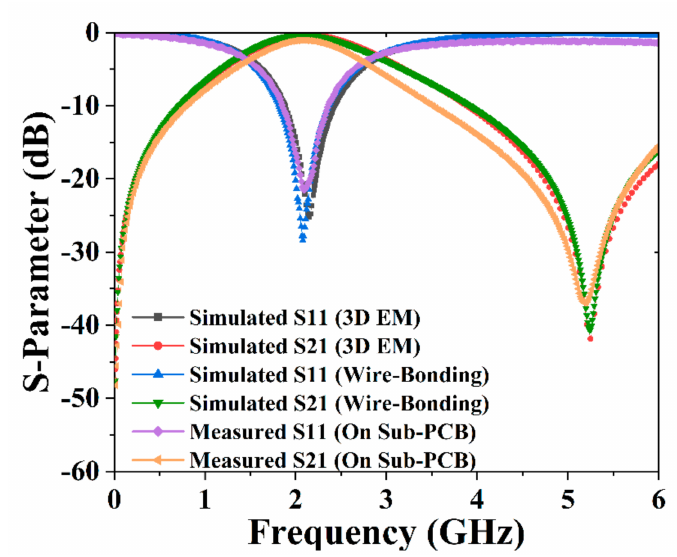
Figure 11. Simulated and measured S-parameter for the proposed BPF. Table 1 list the results in comparison with the performance of other reported BPFs in terms of the detailed substrate and process, insertion loss (IL), return loss (RL), chip area, fraction bandwidth (FBW), center frequency controllability (CFC), transmission zero frequency controllability (TZC), tuning accuracy ratio (TAR), minimum tuning value (MTV), and average tuning value (ATV). It can be seen in the table that our designed BPF possesses a relatively low insertion loss, high return loss, compact chip size, and wide fraction bandwidth. Meanwhile, the tunability of both the center frequency and transmission zero frequency is successfully achieved. Moreover, in comparison with other devices, the designed BPF shows a superior performance in tunability. The relatively lower MTV and ATV prove the excellent fine-tuning ability of the proposed BPF; thus, both the center frequency and transmission zero frequency can be tuned accurately. Additionally, the relatively lower TAR proves that the center frequency and transmission zero frequency can be tuned in a wide range of frequency, which validates that the BPF is competitive in tuning applications. Table 1. Comparison with other reported